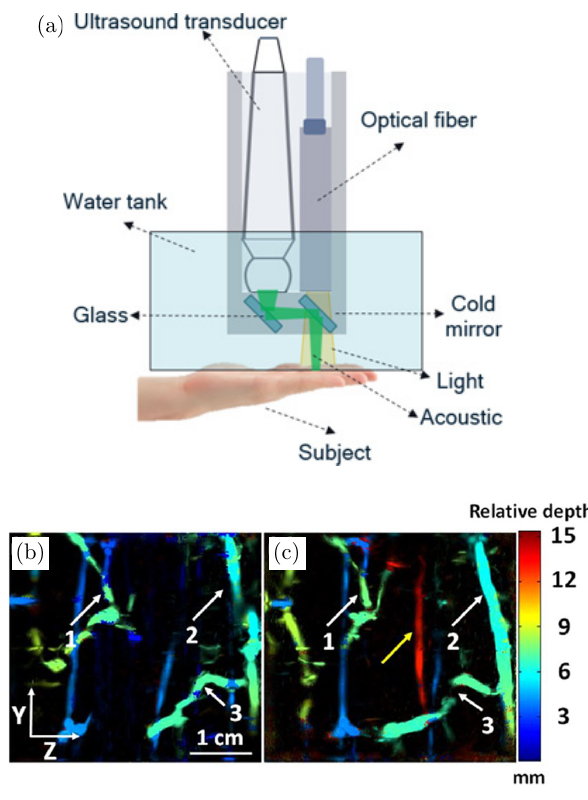
Fig. 8. Schemes of a Double-re°ector PAI system. 47 (a) The cold mirror is transparent to the near-infrared light, while it re°ects acoustic waves by 90 (cid:2) . The secondacoustic re°ection was achieved by a regular glass. (b) Depth-encoded Maximum am- plitude projection (MAP) image of a human forearm, acquired by the side-illumination system. (c) Depth-encoded MAP image of the forearm, acquired by the double-re°ector system. White arrows show the same features and the yellow arrow indicates the deepest vessel. This work by Y. Wang et al. , Ref. 47 is licensed under a Creative Commons Attribution 4.0 International